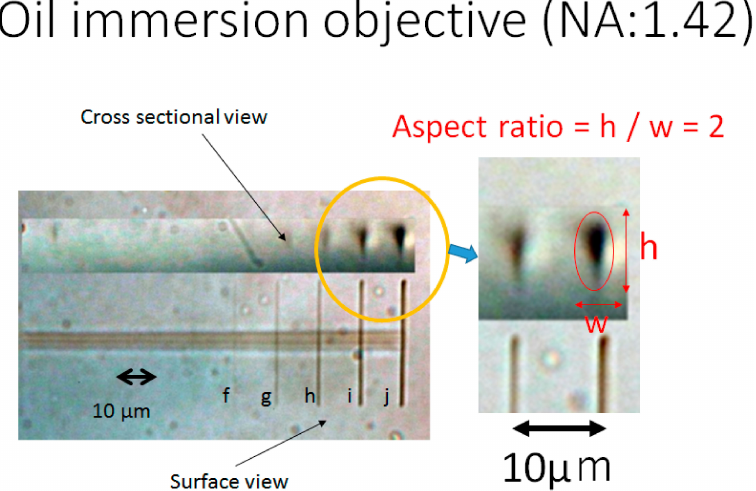
Figure 3. Surface and cross-sectional optical micrographs of photofabricated PEDOT line patterns in transparent Nafion 212 sheet. The photofabrication was carried out by using the oil immersion objective lens (NA: 1.42) and laser focus scanning with a pitch of 0.05 µ m, a wait of 100 ms, incident laser exposure of a: 0.01, b: 0.03, c: 0.07, d: 0.11, e: 0.14, f: 0.19, g: 0.24, h: 0.28, i: 0.32, j: 0.375 mWs, and a repetition rate of 8 MHz. The laser scans were performed 10 times, but five lines were observed from the surface view. (Among them, only four lines could read the